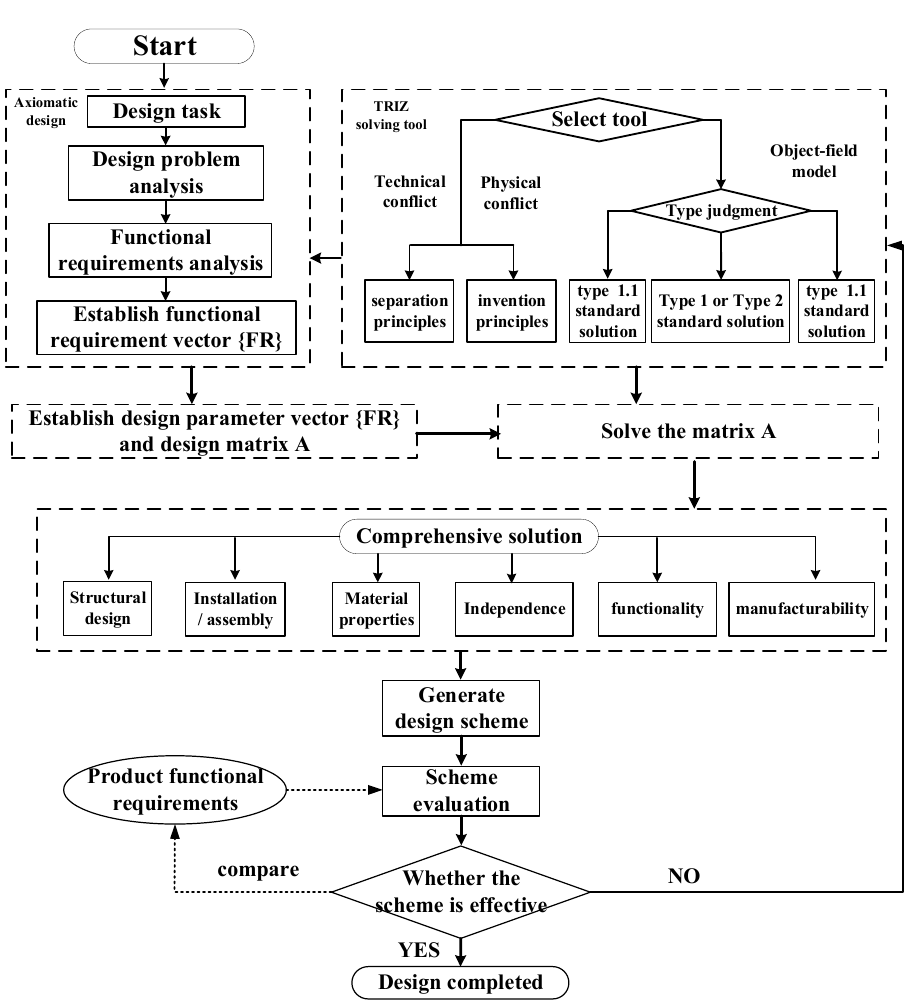
Figure 9. The innovative design process of the conductive center pole.